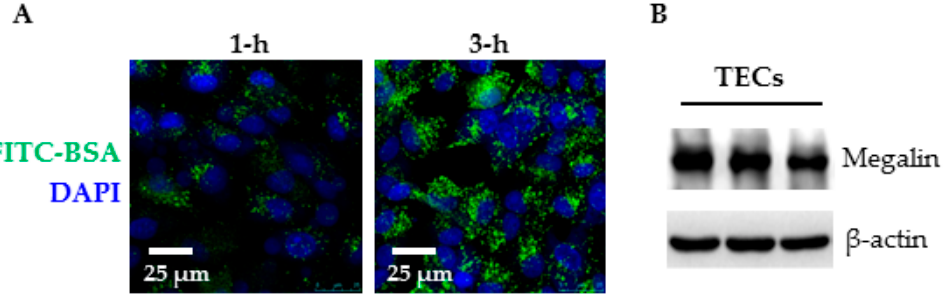
Figure 5. Albumin endocytosis and megalin expression in primary rat TEC. Rat TECs were incubated with 100 µg/mL FITC-BSA at 37 °C for 1 h ( A : 1-h) or 3 h ( A : 3-h) and then washed and fixed. Fluorescence was visualized by confocal microscopy. Representative Western blot images show megalin protein expression in primary TECs ( B ).